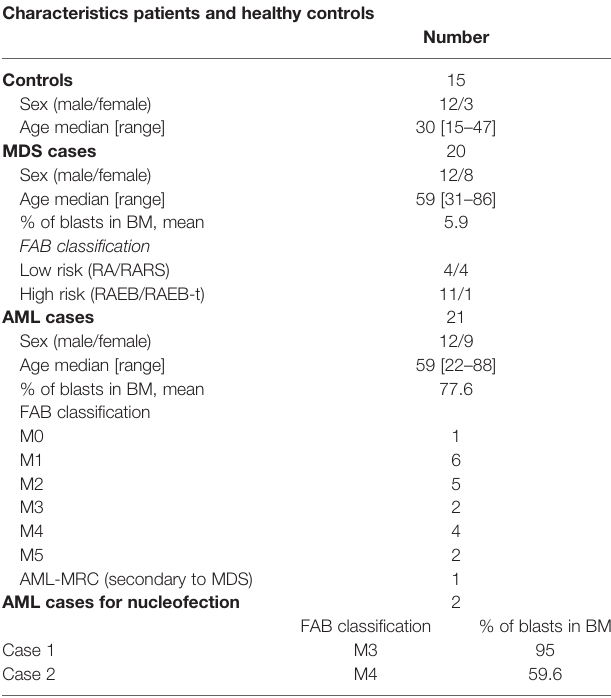
TABLE 1 | Clinical characteristics of patients and healthy controls. Characteristics patients and healthy